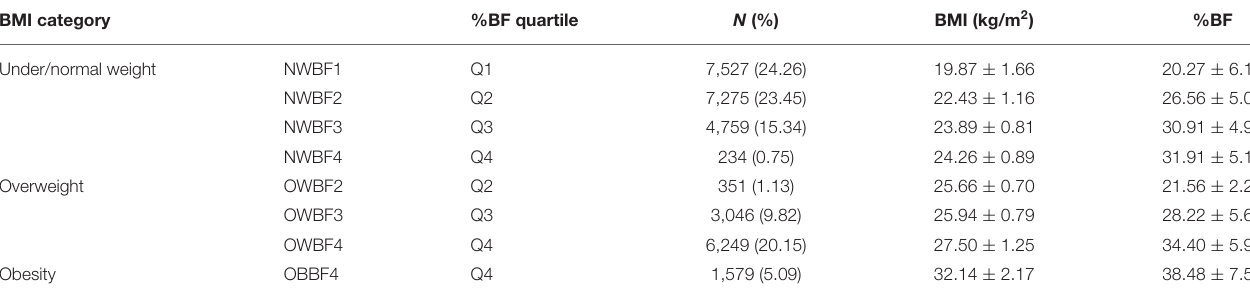
TABLE 1 | Parings of BMI and %BF groups in the study population.